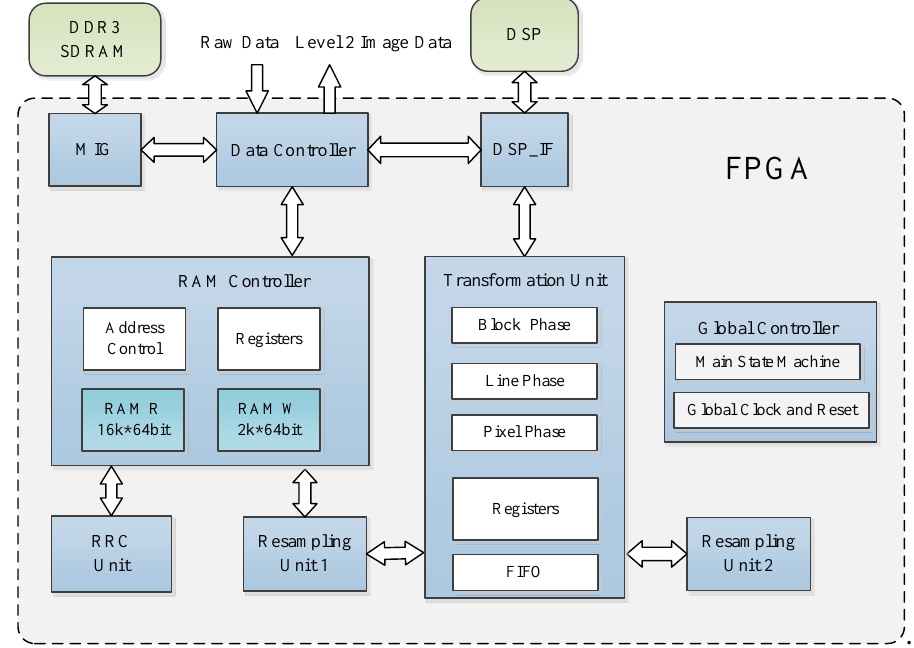
Figure 11. Preprocessing system architecture. FPGA: field-programmable gate array; DSP: digital signal processor; MIG: memory interface generator; RAM: random-access memory; FIFO: first-in-first-out; and SDRAM: synchronous dynamic random-access memory.